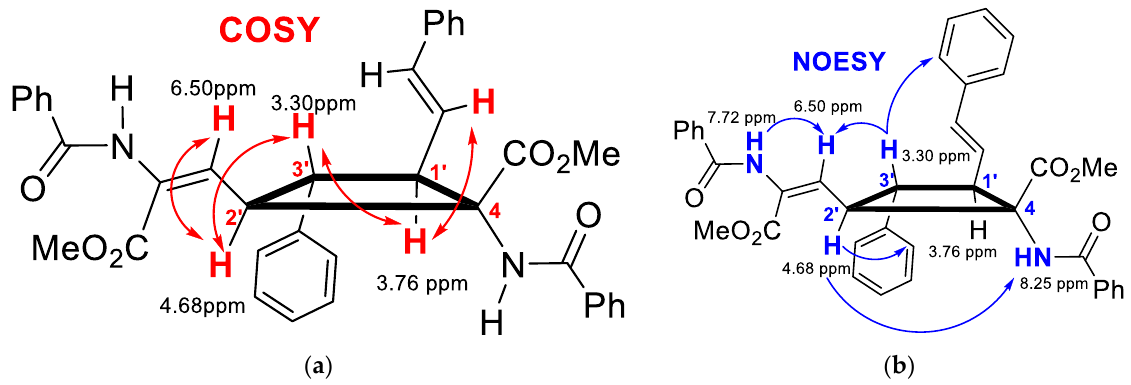
Figure 7. ( a ) Key correlations observed in the 1 H-COSY spectrum of 3a (Figure S71; ( b ) Key correla- tions observed in the 1 H NOESY spectrum of 3a (Figure S72).